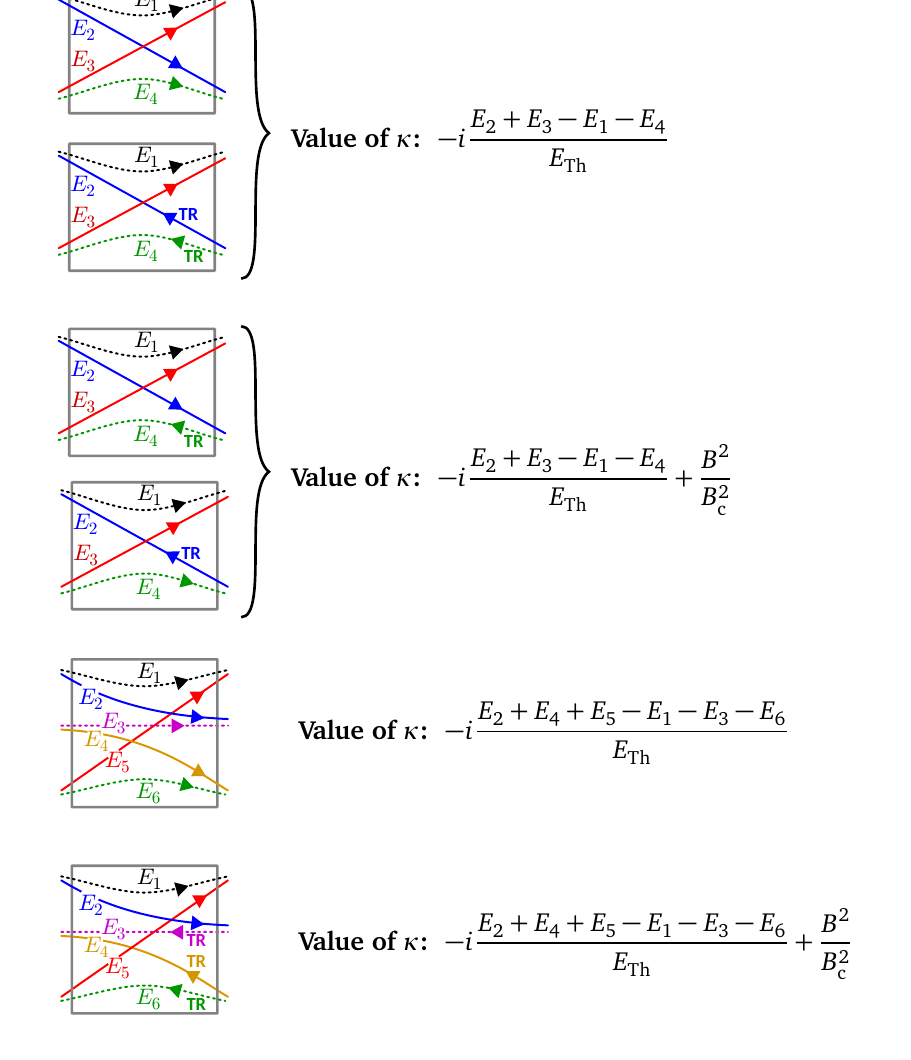
Figure 7: An encounter’s contribution is − N × [ 1 + κ ] , where κ ’s dependence on energies and the magnetic field is different for different encounters. The value of κ for various encounters is given here. Sections VI and VII of Ref. [ 28 ] explain the origin of these